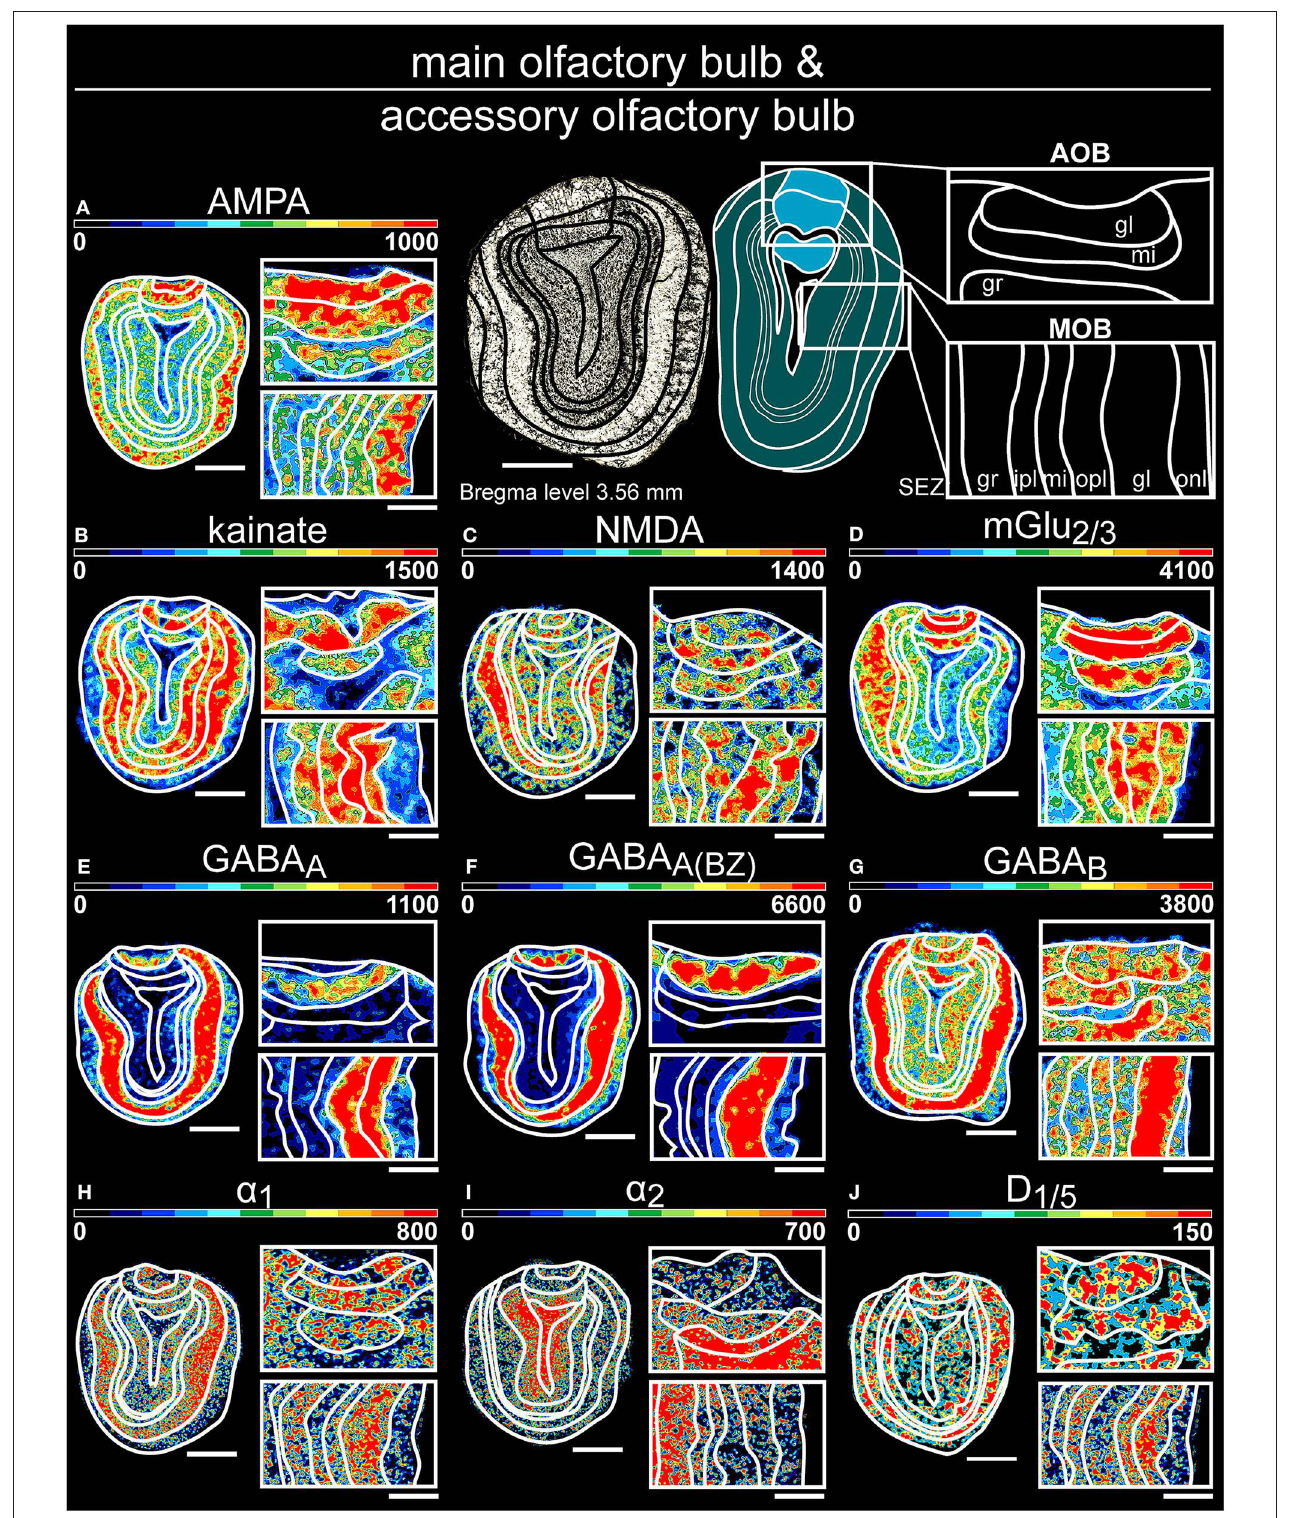
FIGURE 3 | Color-coded autoradiographs showing the distribution and density of all investigated receptors of the main olfactory bulb (A–J) and accessory olfactory bulb (K–T) . Densities of the color-coded autoradiograms in fmol/mg protein according to color scales. For detailed receptor densities see Table 1 . Scale bars: (A–J) , Coronal slice: 1.3mm; Magnifications: 400 µ m; onl, olfactory nerve layer; gl, glomerular layer; mi, mitral layer; ipl, inner plexiform layer; opl, outer plexiform layer; gr, granular layer; SEZ subependymal zone.